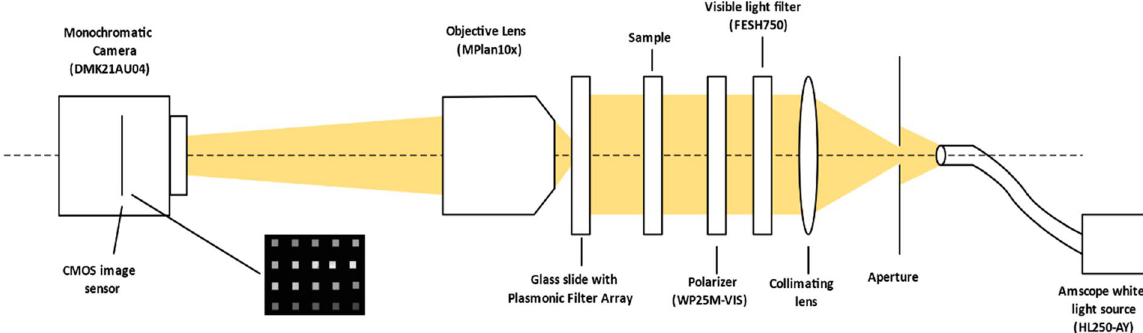
Figure 6. Test setup for taking snapshot images of